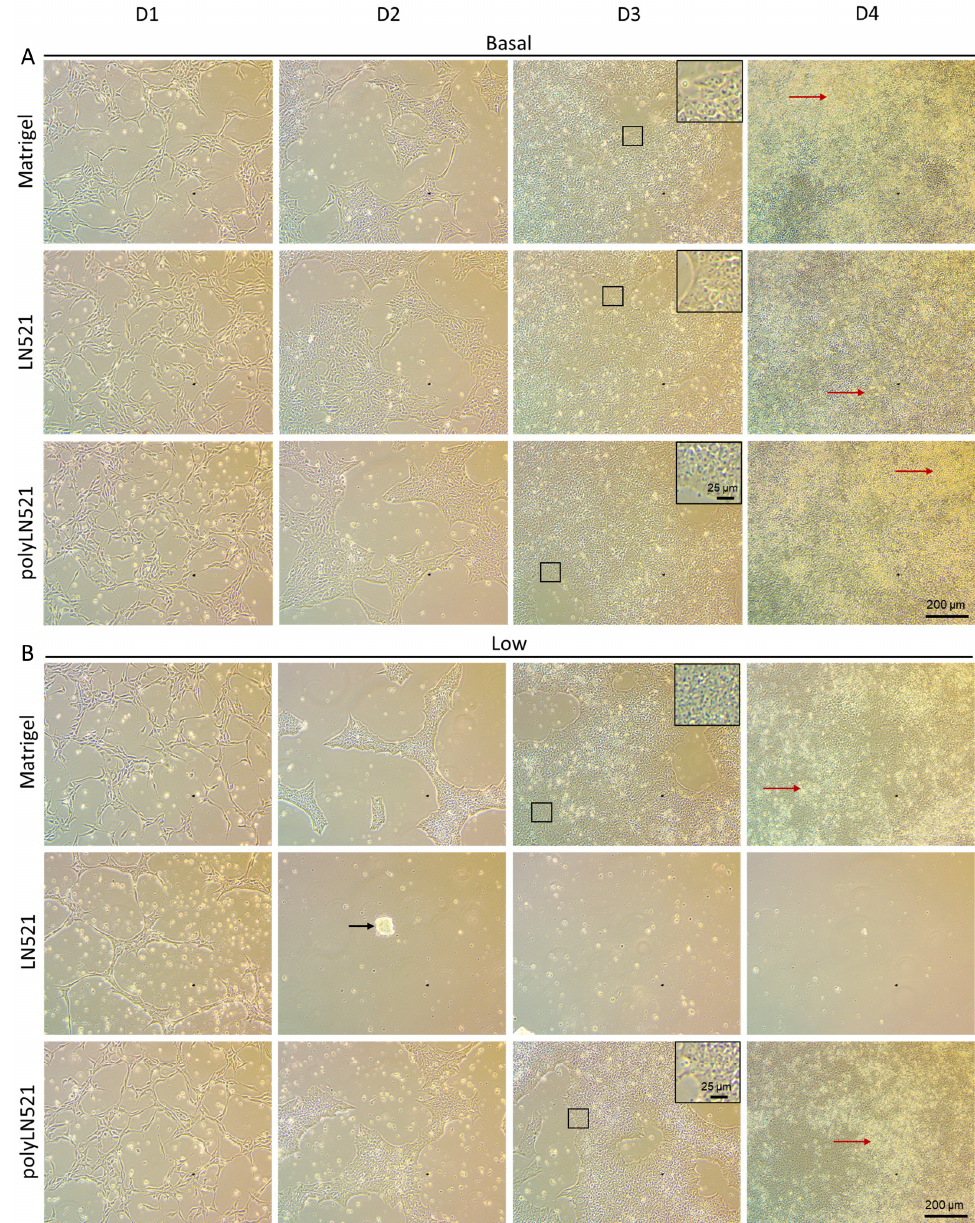
Figure 2. Expansion of human induced pluripotent stem cells (hiPSCs) under different coating conditions. ( A ) Representative bright-field images showing hiPSCs cultivated on basal-Matrigel, basal-LN521, and basal-polyLN521 from day 1 to day 4. ( B ) Representative bright-field images showing hiPSCs cultivated on low-Matrigel, low-LN521, and low-polyLN521 from day 1 to day 4. Insets represent cells with high nuclei to cytoplasm ratios. Red arrows indicate healthy colonies. Black arrow indicates dying cells.